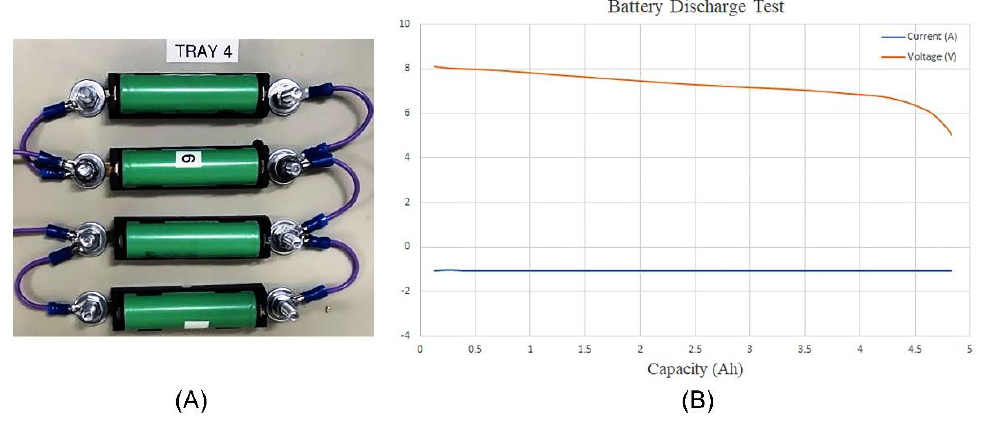
Figure 12. Battery discharge test: ( A ) the test procedure; ( B ) the obtained results.